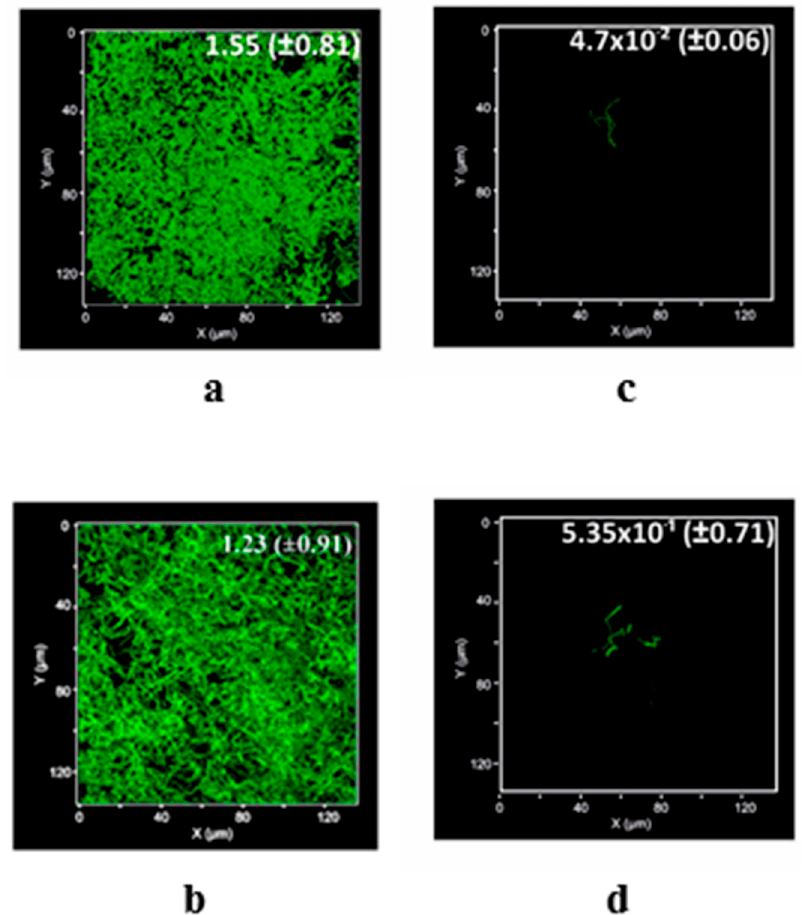
Figure 6. Mean biovolume of B. subtilis ( µ m 3 µ m − 2 ) developed on the uncoated glass surfaces ( a ) or coated by quercetin (Q) ( b ), titanium dioxide-decorated multi-walled carbon nanotubes (MWCNTs/TiO 2 ) ( c ), and quercetin titanium dioxide-decorated multi-walled carbon nanotubes (Q/MWCNTs/TiO 2 ) ( d ).